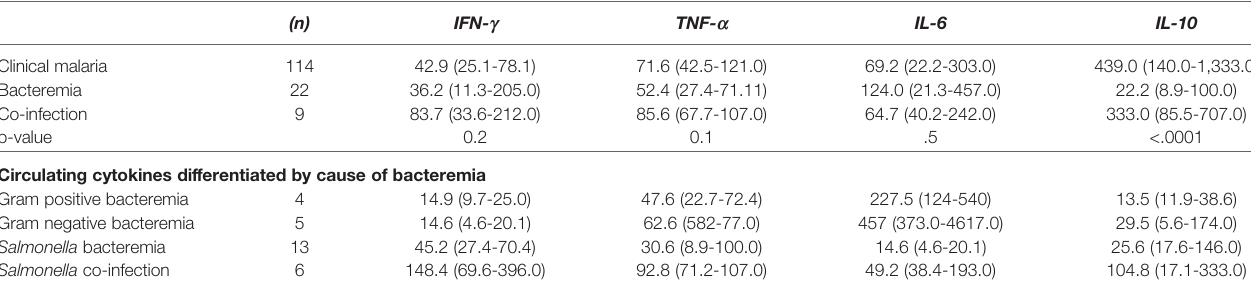
TABLE 3 | Circulating cytokines among patients with clinical malaria, bacteremia, and combined malaria-bacteremia infection. (n) Clinical